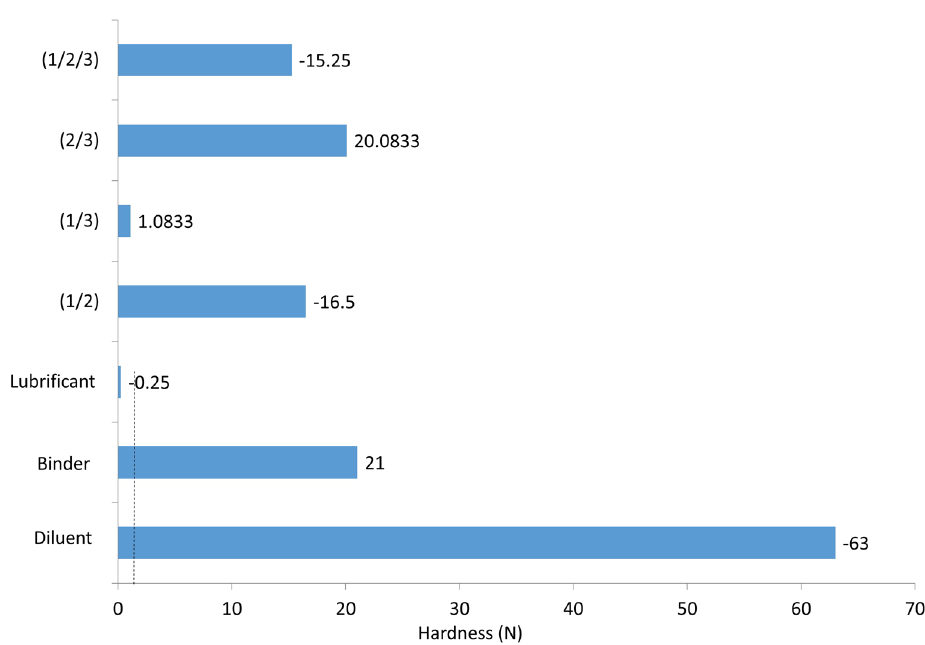
FIGURE 1 - Pareto Graph for factorial planning 2 3 results, considering the effects produced in the hardness. Dashed line defines 95% confidence interval. Interaction of parameters 1 and 2 (1/2); Interaction of parameters 1 and 3(1/3); Interaction of parameters 2 and 3 (2/3); and Interaction of parameters 1, 2 and 3 (1/2/3).